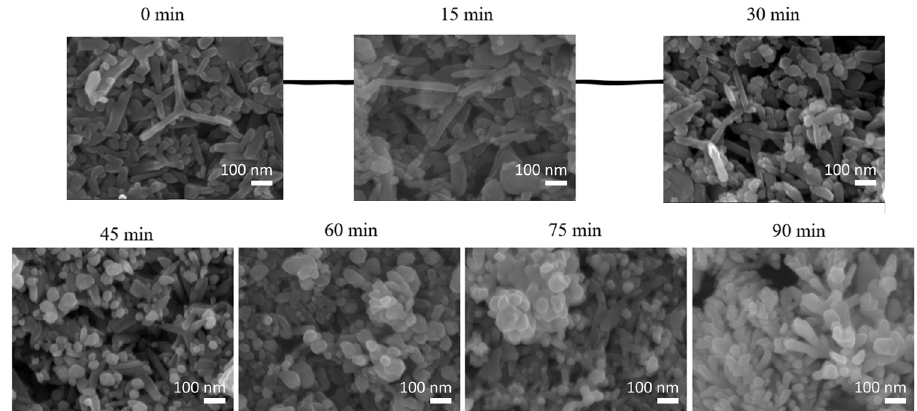
Figure 2. FE-SEM images of Ag@ZnO-ITO at various irradiation times.